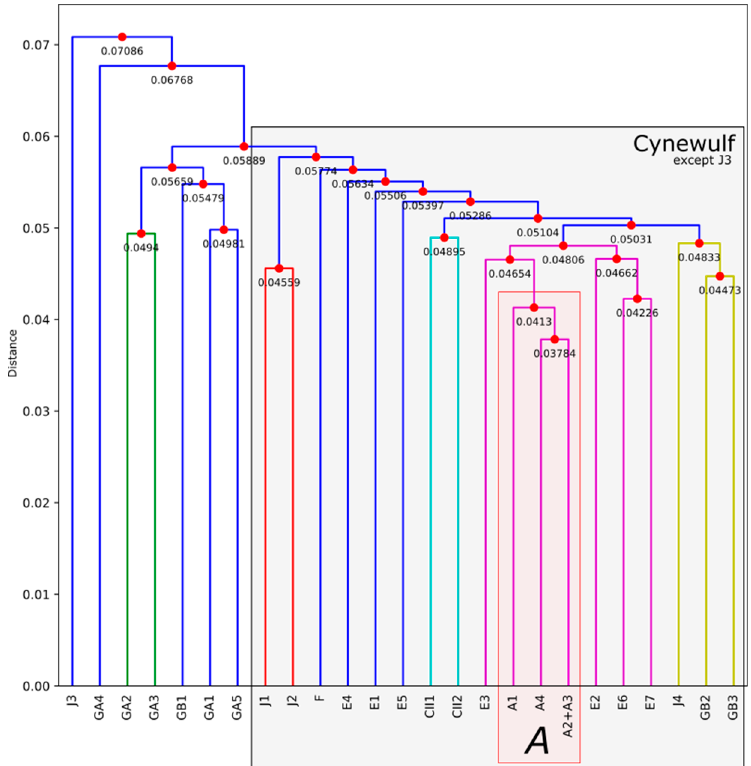
Figure 14. Andreas A with the Cynewulfian group. Humanities 2019 , 8 , x FOR PEER REVIEW